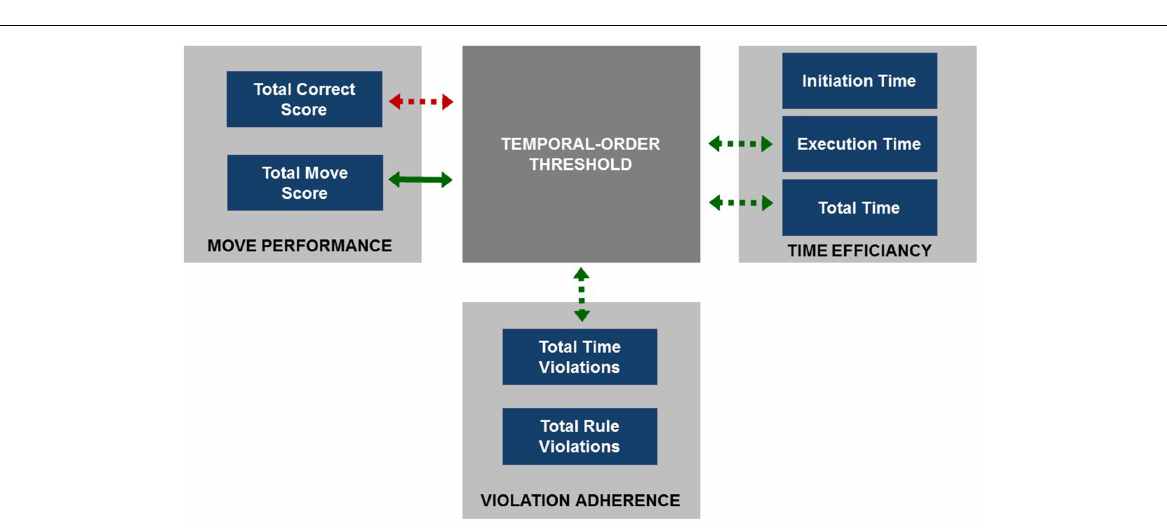
FIGURE 6 | The summary of relationships between TOT (dark gray square) and particular outcome measures of TOL DX grouped into three categories (light gray squares). Green arrows indicate significant positive correlations and the red one the negative correlation between TOT and TOL DX outcome measures. The correlation significant after controlling for ‘age’ is specified with solid arrow whereas those non-significant with dashed